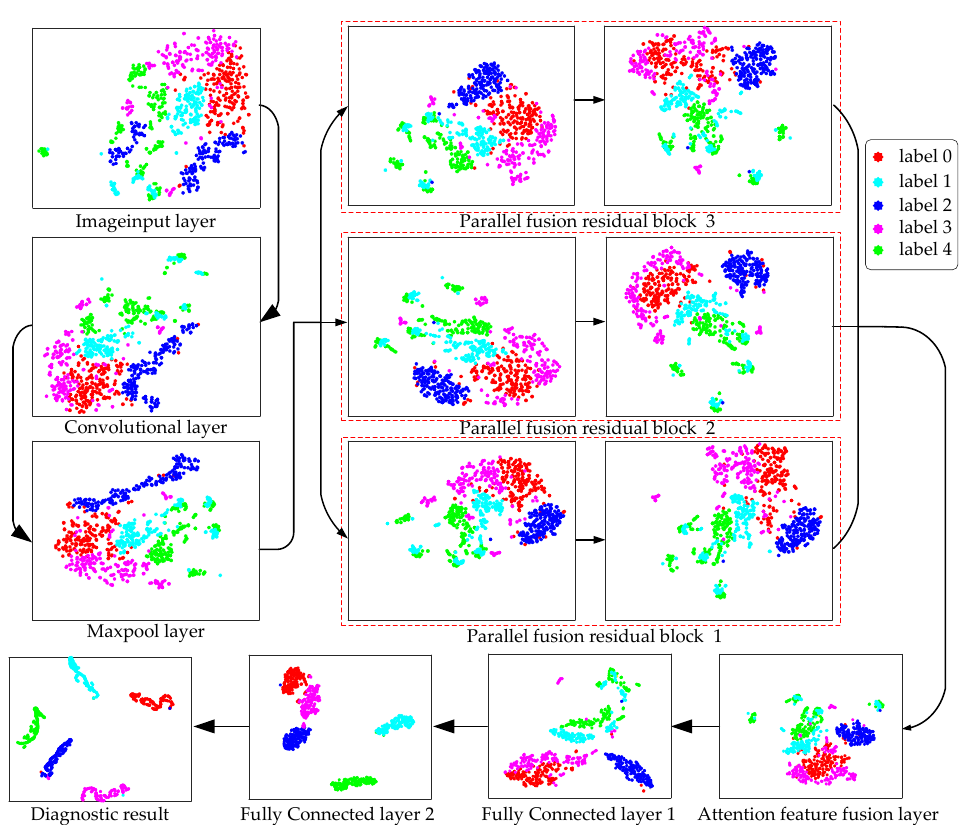
Figure 18. T-SNE visualization of bearings.